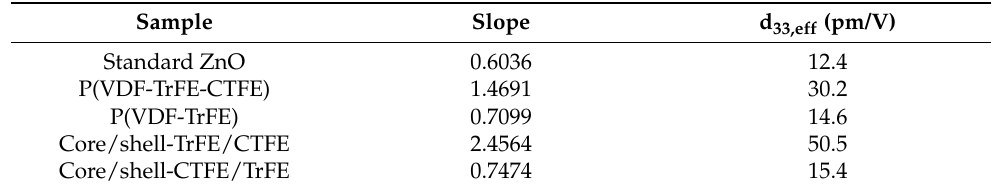
Table 2. The slope of piezoelectric amplitude response and corresponding d 33,eff in the four electro- spun